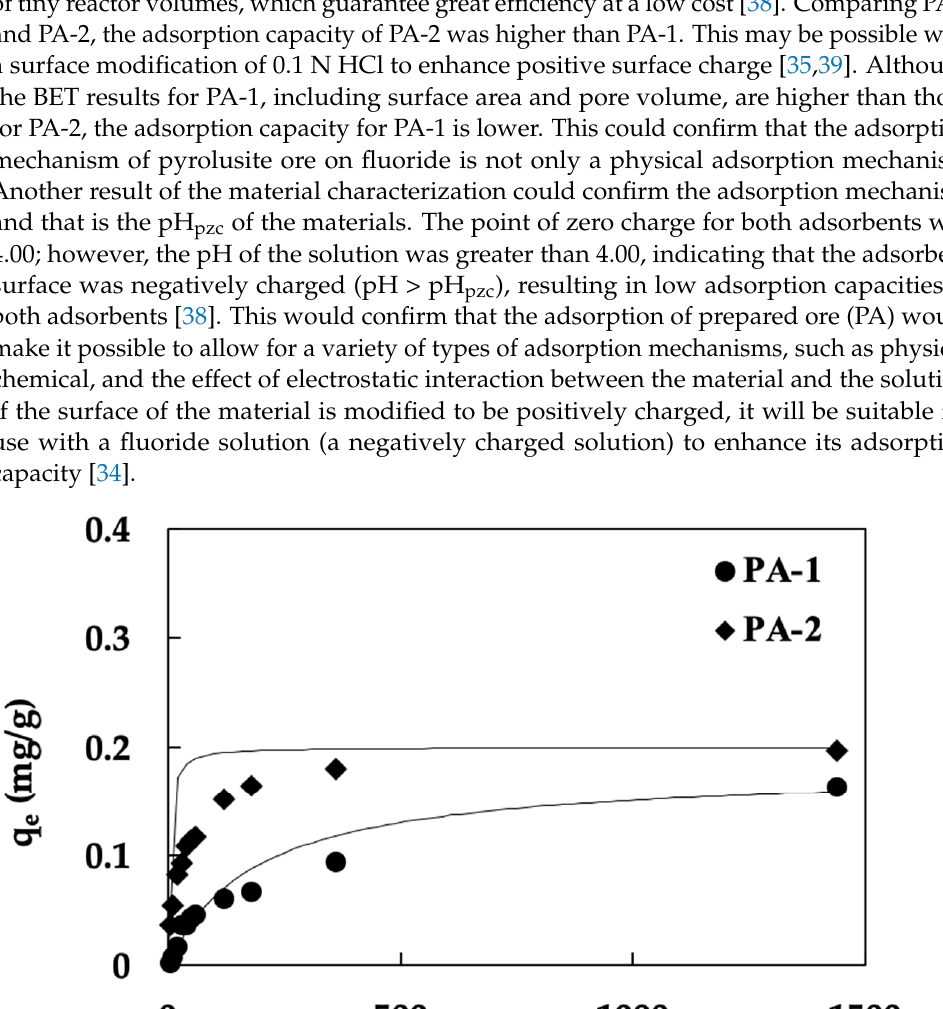
Table 4. Kinetic parameter of fluoride by pseudo-first order and pseudo-second order model.